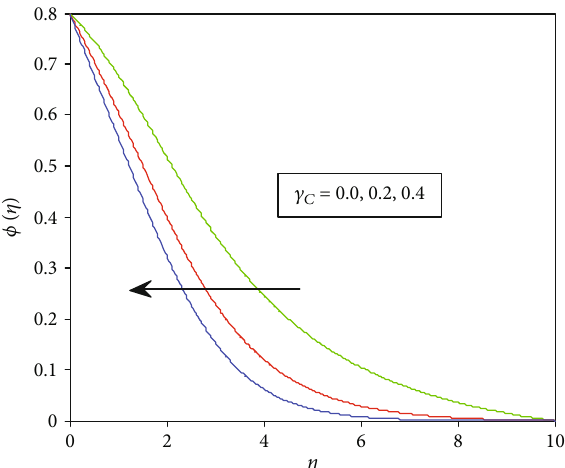
Figure 23: Concentration distribution for di ff erent values of N